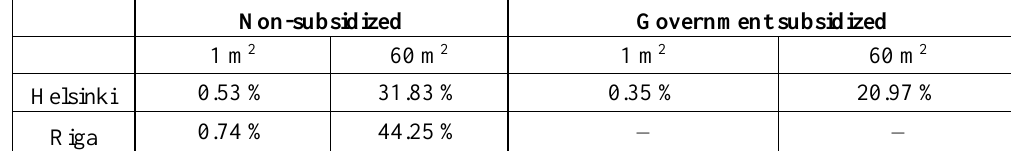
Table 3. Rent as Percentage of Disposable Income per Household (developed by the authors, based on based on CSB, 2015b, Statistics Finland’s PX-Web databases,